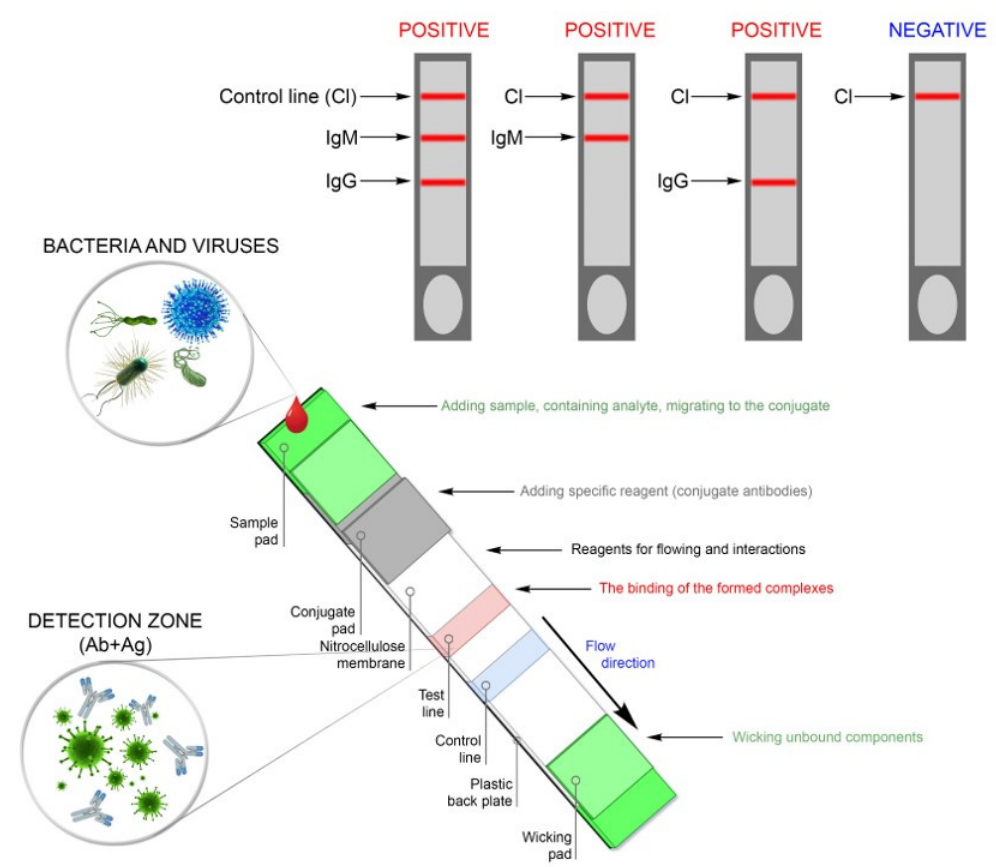
Figure 4. Schematic representation of the construction of the lateral flow immunoassay (LFIA) test system and interpretation of the results. Table 4. Lateral flow immunoassay (LFIA) test systems approved for the diagnosis of COVID-19 [78]. Country of Origin